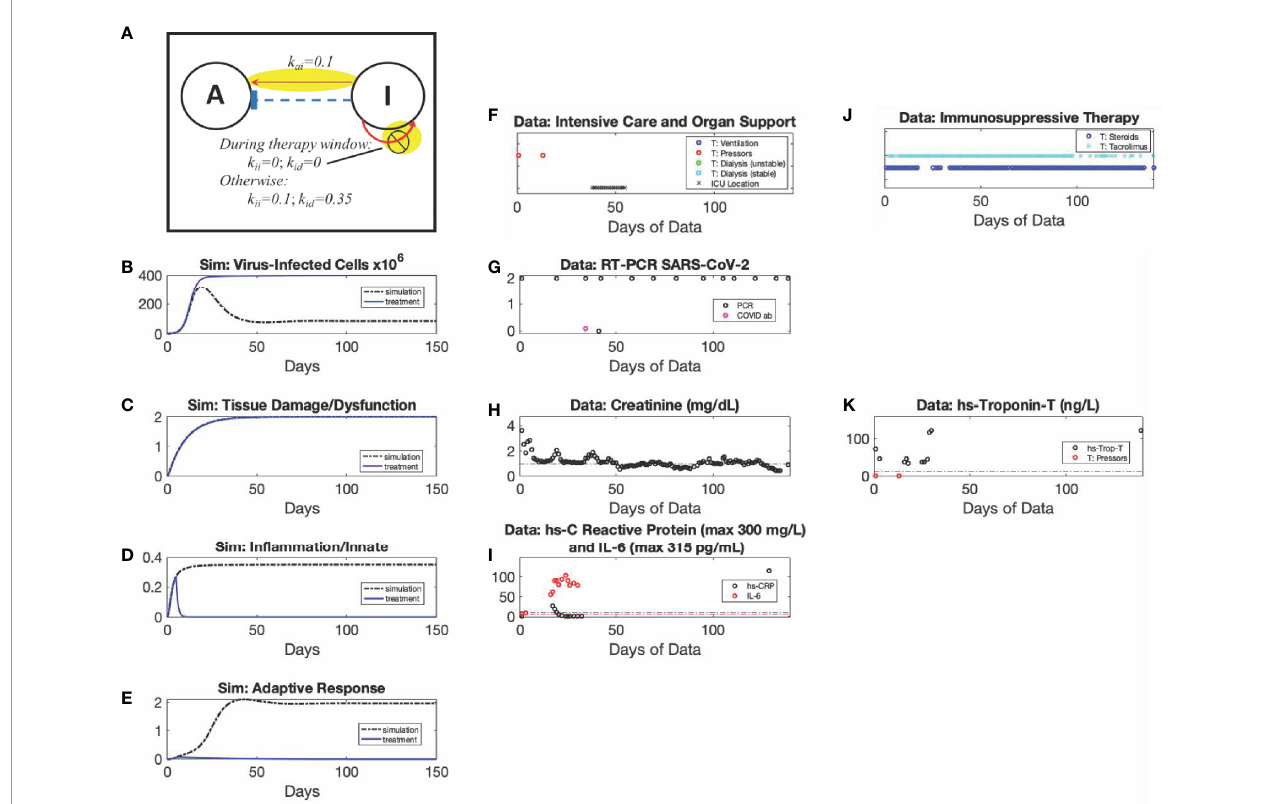
FIGURE 8 | Uncontrolled Infection archetype and Long-duration Anti-in fl ammatory Treatment: simulation vs . patient data. The Uncontrolled Infection archetype emerges due to modifying the value of parameter k ai compared to the Recovery archetype, Mild scenario; and, when implementing the window of anti-in fl ammatory therapy, k ii and k id are set to zero as shown in the diagram (Panel A ). Simulated dynamics are shown of C V (Panel B ) (Initialized with a C V =8x10 5 virus-infected cells), D (Panel C ), I (Panel D ), and A (Panel E ) for the Uncontrolled Infection archetype (black, dot-dashed curves, Panels B – E ). An anti-in fl ammatory treatment simulation of this archetype is overlayed (blue, solid curves, Panels B – E ). Panels (F – K) show data from a patient in their 60s who was chronically immunosuppressed after a solid organ transplant who presented after weeks of diarrhea and failure to thrive. The patient was found to be in renal failure and SARS-CoV-2 PCR positive.